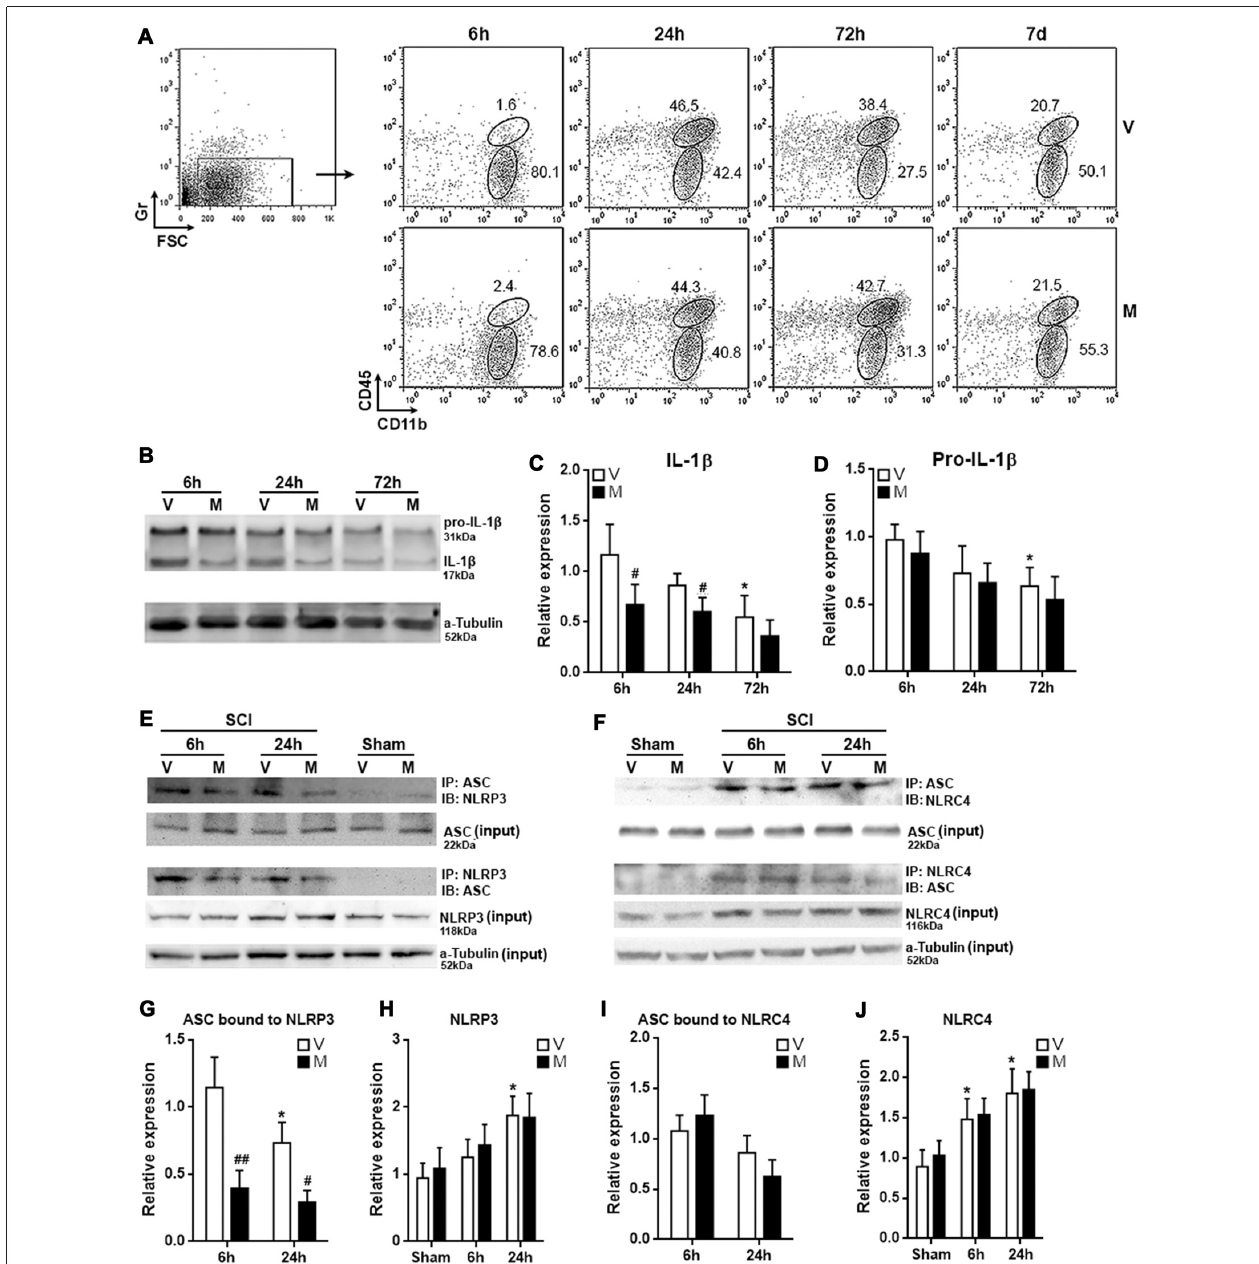
FIGURE 4 | Methylene blue inhibits NLRP3 inflammasome formation in post-spinal cord injury (SCI) microglia. (A) Proportions of microglia and macrophages in spinal cords at indicated time points post SCI. Gr − CD45 low CD11b + microglia and Gr − CD45 hi CD11b + macrophages were distinguished in spinal cord immune cells from 6 h to 7 days post SCI. These are representative dot plots of three independent experiments. Note that the leftmost dot plot showing the gating of Gr-negative cells was a sample collected 6 h post SCI. This is why only a small amount of Gr-positive cells were seen. Numbers in the plots are proportions of each gated population. (B–D) Expression of pro-IL-1 β and mature IL-1 β in microglia sorted from post-SCI spinal cords. Representative Western blot images are shown in (B) , statistical analysis is shown in (C,D) , respectively. N = 3 per group. (E) Representative images of Co-immunoprecipitation assay for the binding of ASC to NLRP3 in post-SCI microglia. IP: immunoprecipitation with the antibody against indicated protein. IB: detection of indicated protein. (F) Representative images of Co-immunoprecipitation assay for the binding of ASC to NLRC4 in post-SCI microglia. (G–J) Statistical analysis for the ASC bound to NLRP3 (G) or NLRC4 (I) , and for the expression of NLRP3 (H) or NLRC4 (J) . N = 5 per group. V: vehicle; M: methylene blue treatment. To analyze the relative expression of target proteins in (C,D) , the band intensities of target proteins were normalized to corresponding band intensities of α -Tubulin, followed by calculating the target protein expression in other groups relative to “6 h (V)” group. For the quantification in (G–J) , target proteins were normalized to α -Tubulin, followed by calculating the target protein expression in other groups relative to “Sham (V)” group. ∗ p < 0.05 in comparison with the “6 h” vehicle group or sham group (if any). # p < 0.05; ## p < 0.01 in comparison with the corresponding vehicle group at each time